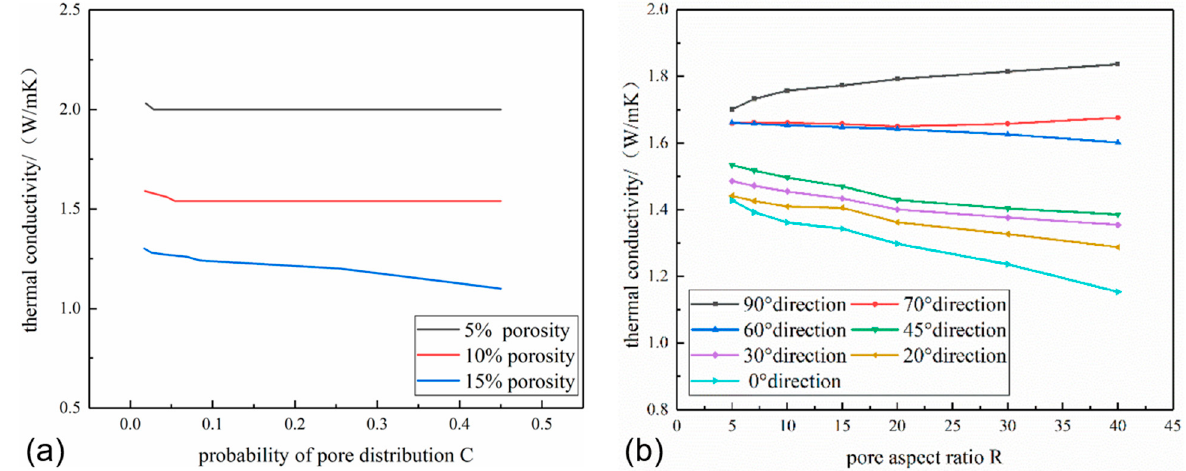
Figure 14. The evolution of thermal conductivity ( a ) with pore sizes at different total porosities ( b ) with pore angles at different pore aspect ratios [73] .